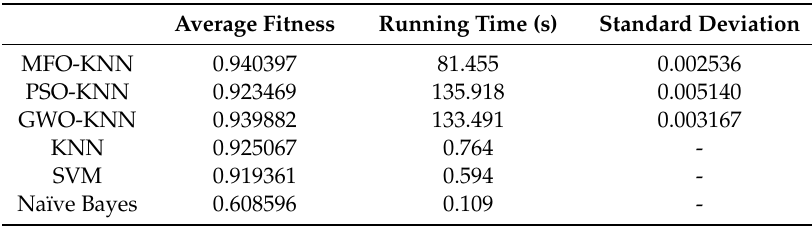
Table 2. Experimental results of 4000 data